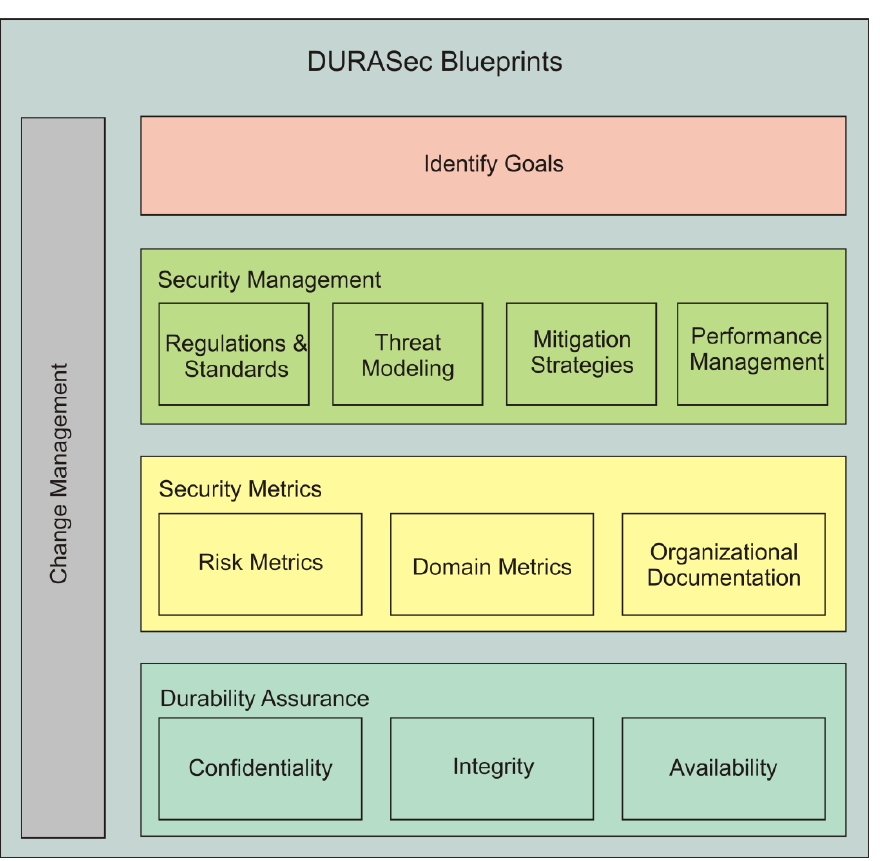
Figure 6. DURASec Blueprints Architecture for